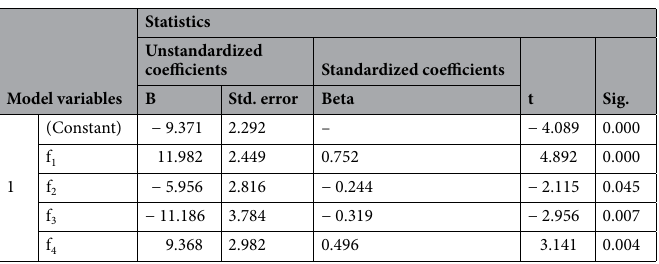
Table 7. Coefficients. Dependent variable: y.